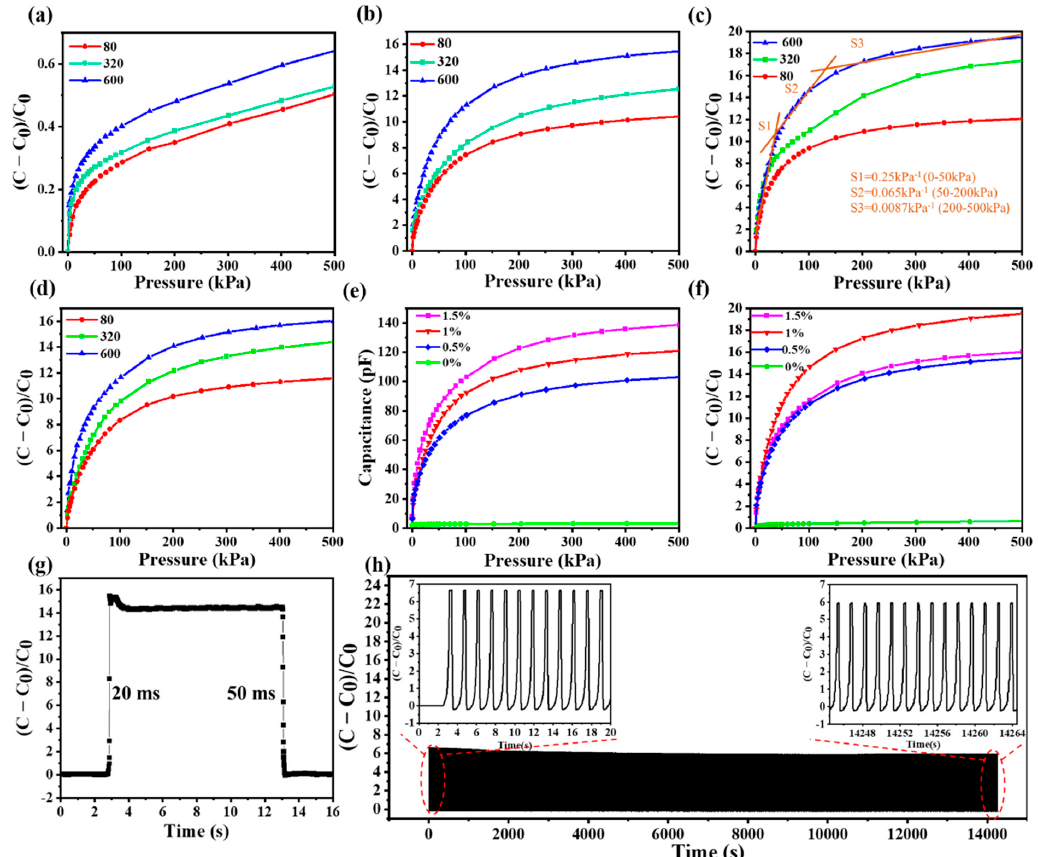
Figure 2. Sensing performances of the pressure sensors. ( a ) Pressure response of relative capacitance change in the sensor with ( a ) 0, ( b ) 0.5, ( c ) 1 and ( d ) 1.5 wt% CNT doping content using different abrasive papers. ( e ) Pressure response of the absolute capacitance of the sensor using abrasive paper no. 600 under different doping contents of CNTs. ( f ) Pressure response of the relative capacitance of the sensor using abrasive paper no. 600 under different doping contents of CNTs. ( g ) Response time and recovery time of the spinosum pressure sensor. ( h ) Durability test of the pressure sensor for 10,000 loading/unloading cycles at the pressure of 30